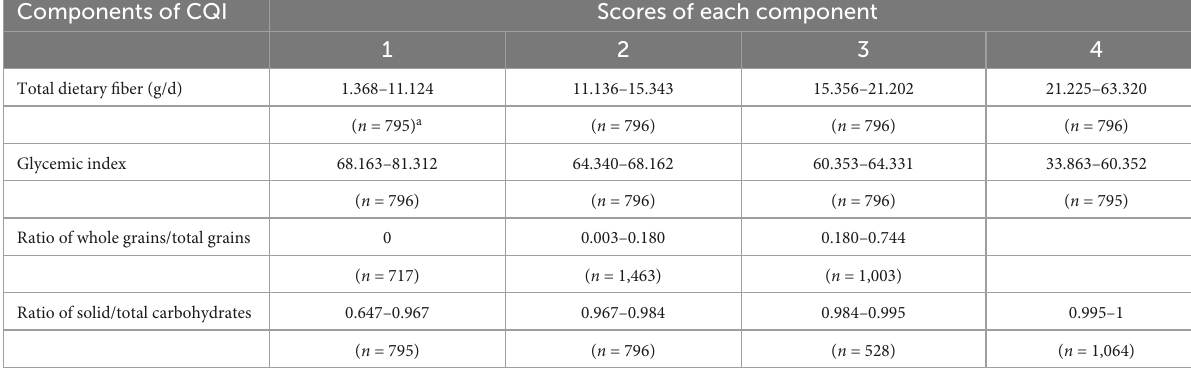
TABLE 1 Components and calculation formula of CQI. Components of